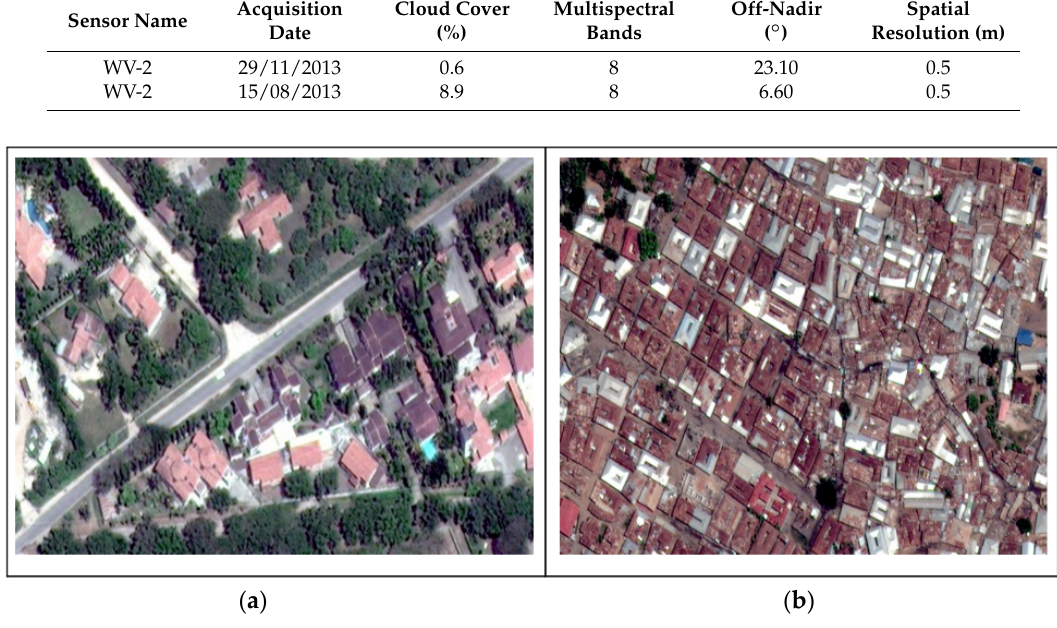
Figure 4. Planned areas ( a ) and unplanned areas ( b ) (informal settlements).